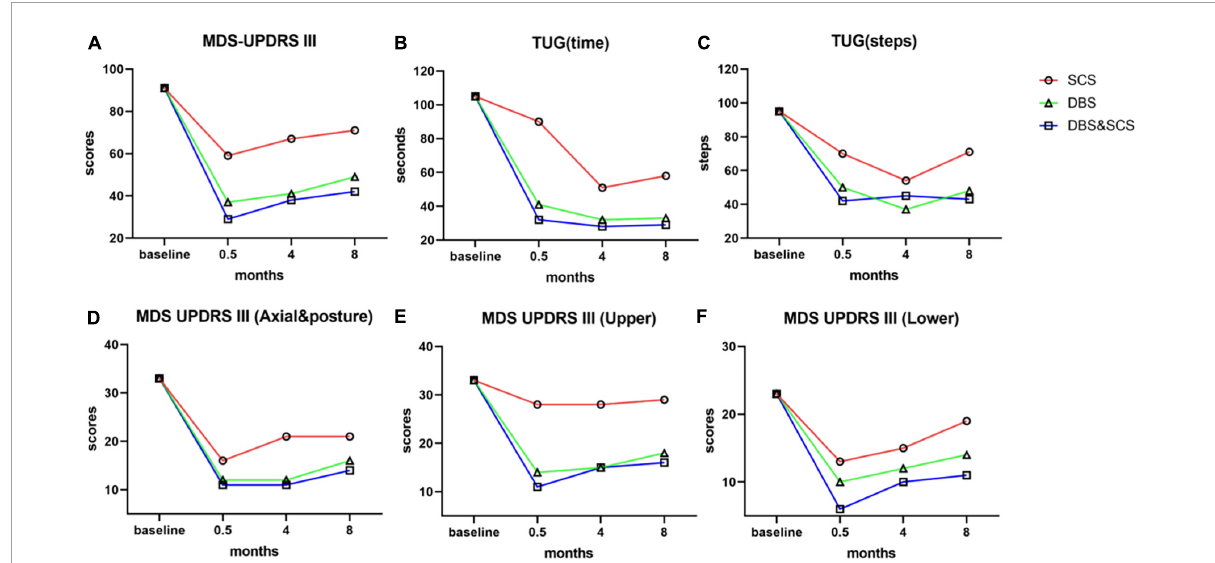
FIGURE2 The outcomes of MDS-UPDRS III and TUG in the medication-off state prior to surgery and at 0.5- (phase I trials), 4-, and 8-month postoperative. The stimulation test was performed separately, and the outcome was evaluated double-blindly at all follow-ups. (A–C) Outcome of total scores of MDS-UPDRS III (A) , time (B) , and steps (C) of the 7-m TUG by SCS stimulation (red lines), DBS stimulation (green lines), and DBS and SCS stimulation (blue lines). The combined stimulation of DBS and SCS showed a better improvement in MDS-UPDRS III and TUG than either SCS or DBS stimulation. (D–F) Subscores of MDS-UPDRS III, axial and posture subscores (D) , upper-limb subscores (E) , and lower-limb subscores (F) of MDS-UPDRS III. Axial and posture subscores: items 3.1, 3.2, 3.3, 3.9, 3.10, 3.11, 3.12, 3.13, and 3.14; upper-limb subscores: items 3.3, 3.4, 3.5, 3.6, 3.15, 3.16, and 3.17; lower-limb subscores: items 3.3, 3.7, 3.8, and 3.17. DBS stimulation and DBS and SCS stimulation did significantly improve the cardinal parkinsonian symptoms, and the improvement of upper limbs and axial symptoms mainly benefits from DBS